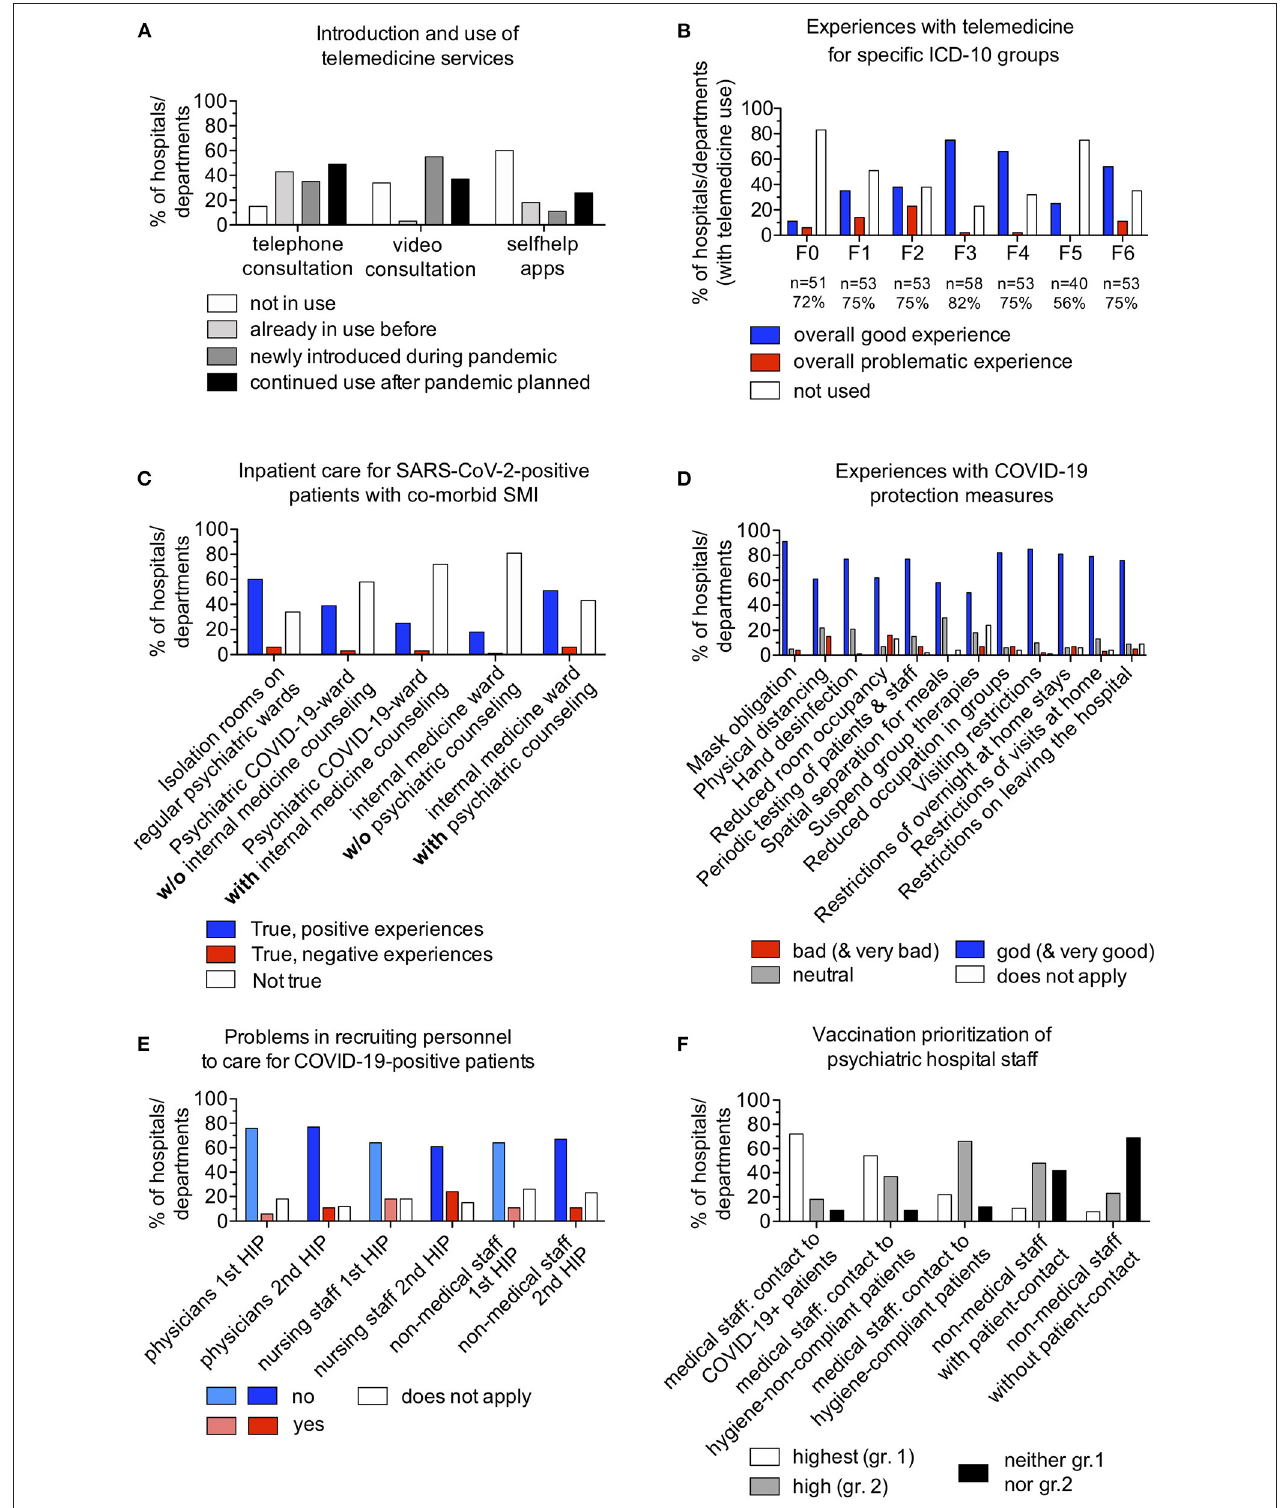
FIGURE 2 | (A) shows findings about the introduction and use of telemedicine services during the pandemic. (B) shows experiences with telemedicine services for specific ICD-10 groups. F0, organic mental disorders; F1, addiction disorders; F2, psychoses; F3, affective disorders; F4, neurotic, stress-related and